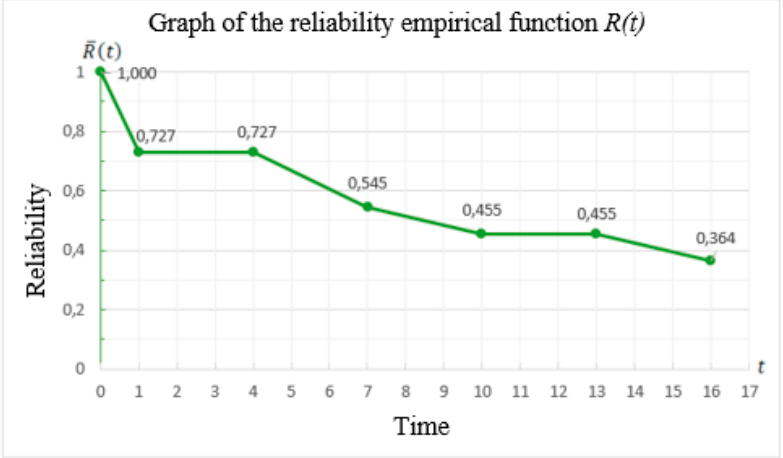
Figure 3. Reliability empirical function waveform.